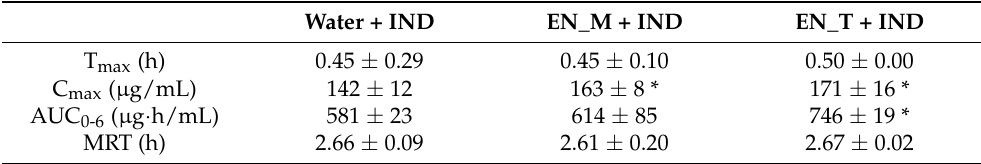
Table 1. Pharmacokinetic parameters calculated from time courses of plasma IND